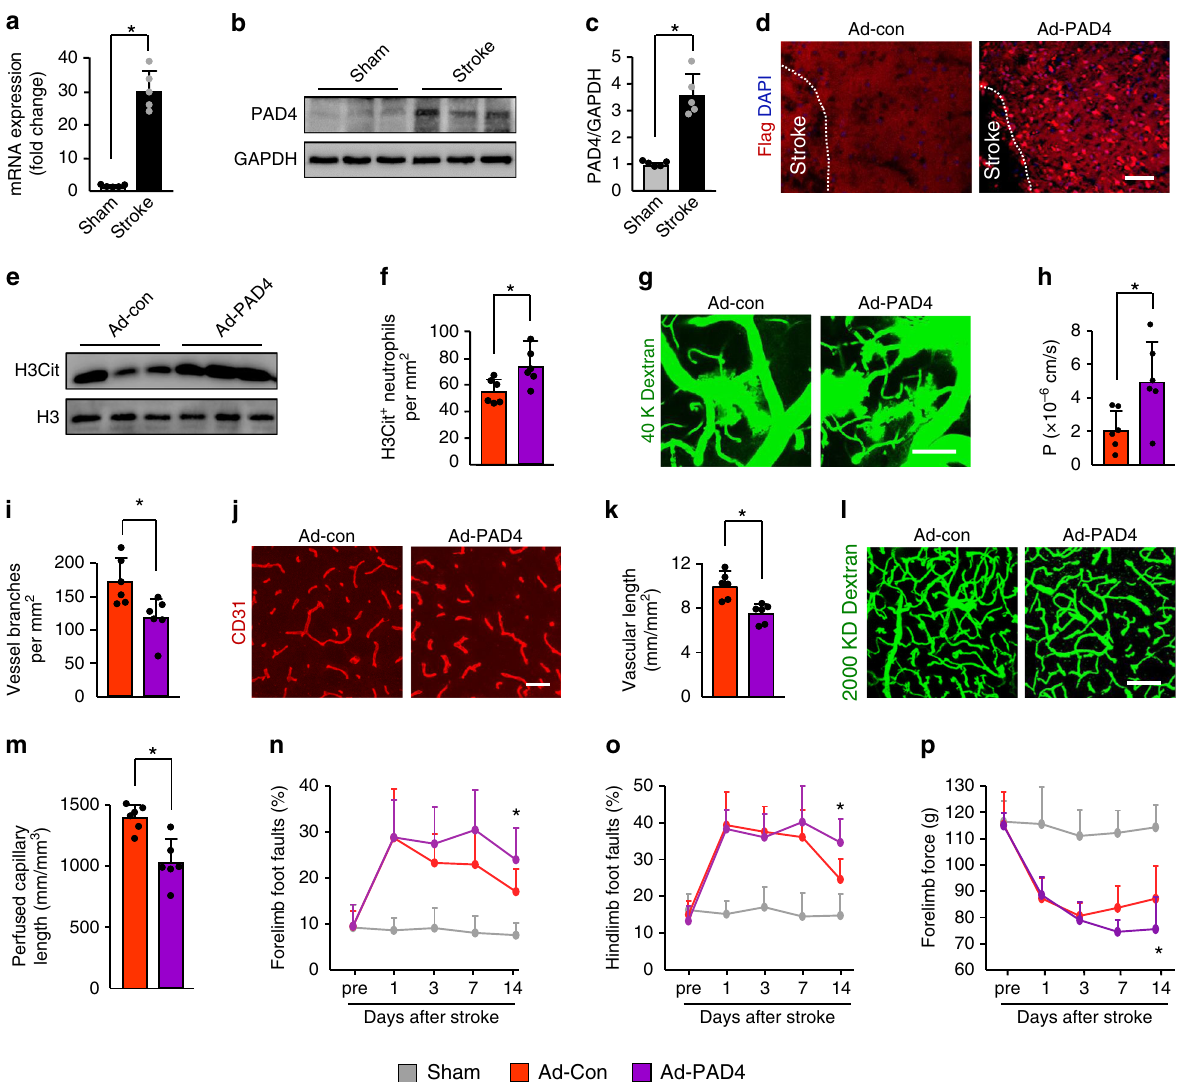
Fig. 6 Overexpression of PAD4 exacerbates BBB breakdown and reduced revascularization. a PAD4 mRNA expression was measured by quantitative real-time PCR in the peri-infarct cortex at 3 days, compared with sham-operated mice ( n = 5); Mann – Whitney test was applied with * P = 0.0079. b , c Representative immunoblots ( b ) and quanti fi cation of PAD4 levels ( c ) in the peri-infarct cortex at 4 days after injection of control (Ad-Con) or PAD4 adenovirus (Ad-PAD4) ( n = 5); Mann – Whitney test was applied with * P = 0.0079). d Representative images of recombinant Adeno-PAD4- fl ag-infected cells in the ischemic cortex. Mice were treated with recombinant Adeno-PAD4- fl ag (right panel) or empty adenovirus (left panel). At 4 days after injection, brain sections were stained with an antibody against Flag. Bar = 40 μ m. e Representative immunoblots of H3Cit levels in the peri-infarct cortex at 3 days. f Quanti fi cation of the numbers of H3Cit-positive neutrophils in the peri-infarct cortex at 4 days after injection of control or PAD4 adenovirus ( n = 6); unpaired two-tailed Student ’ s t -test was applied with * P = 0.0230. g In-vivo multiphoton microscopic images of intravenously injected FITC-dextran (MW = 40,000 Da; green) leakage in cortical vessels at 14 days. Bar = 100 μ m. h Quanti fi cation of the permeability (P) product of FITC-dextran for each group ( n = 6); unpaired two-tailed Student ’ s t -test was applied with * P = 0.0244. i Quanti fi cation of vascular branches in mice treated with control or PAD4 adenovirus at 14 days after stroke ( n = 6), unpaired two-tailed Student ’ s t -test was applied with * P = 0.0170. j , k Confocal images of CD31-positive microvessels ( j ) and quanti fi cation of microvascular density ( k ) in the peri-infarct cortex at 14 days ( n = 6), unpaired two-tailed Student ’ s t -test was applied with * P = 0.0019. Bar = 50 μ m. l , m In-vivo multiphoton microscopic images of perfused cortical capillaries with intravenously injected FITC- dextran ( l ) and quanti fi cation of perfused capillary length ( m ) at 14 days after stroke ( n = 6), unpaired two-tailed Student ’ s t -test was applied with * P = 0.0017. Bar = 100 μ m. n – p Overexpression of PAD4 worsened neurological outcomes in beam walking test ( n , o ) and forelimb force test ( p ) ( n = 10). One-way ANOVA test was applied with * P = 0.001 ( n ), * P = 0.0015 ( o ), * P < 0.0001 ( p ) (Sham and Ad-Con). * P = 0.0015 ( n ), * P = 0.0015 ( o ), * P = 0.0279 ( p ) (Ad-Con and. Ad-PAD4). Data are presented as mean ± SD. Source data underlying graph a – c , e , f , h , i , k , m – p are provided as a Source Data fi le. We found a marked tenfold increase in the levels of IFN- β in the and TBK1-dependent IFN regulatory factor 3 (IRF3) activation cortical areas at 3 days after stroke (Fig. 8a), suggesting activation (Fig. 8b and Supplementary Fig. 10b, c). Treatment with the PAD of the STING pathway. We then detected signi fi cantly increased inhibitor Cl-amidine reduced the levels of stroke-induced levels of STING (Fig. 8b and Supplementary Fig. 10a) and robust STING-meditated signaling in the cortical areas compared with induction of phosphorylated TANK-binding kinase 1 (pTBK1) vehicle-treated mice (Fig. 8c, d and Supplementary Fig. 10d – f). NATURE COMMUNICATIONS| (2020) 11:2488